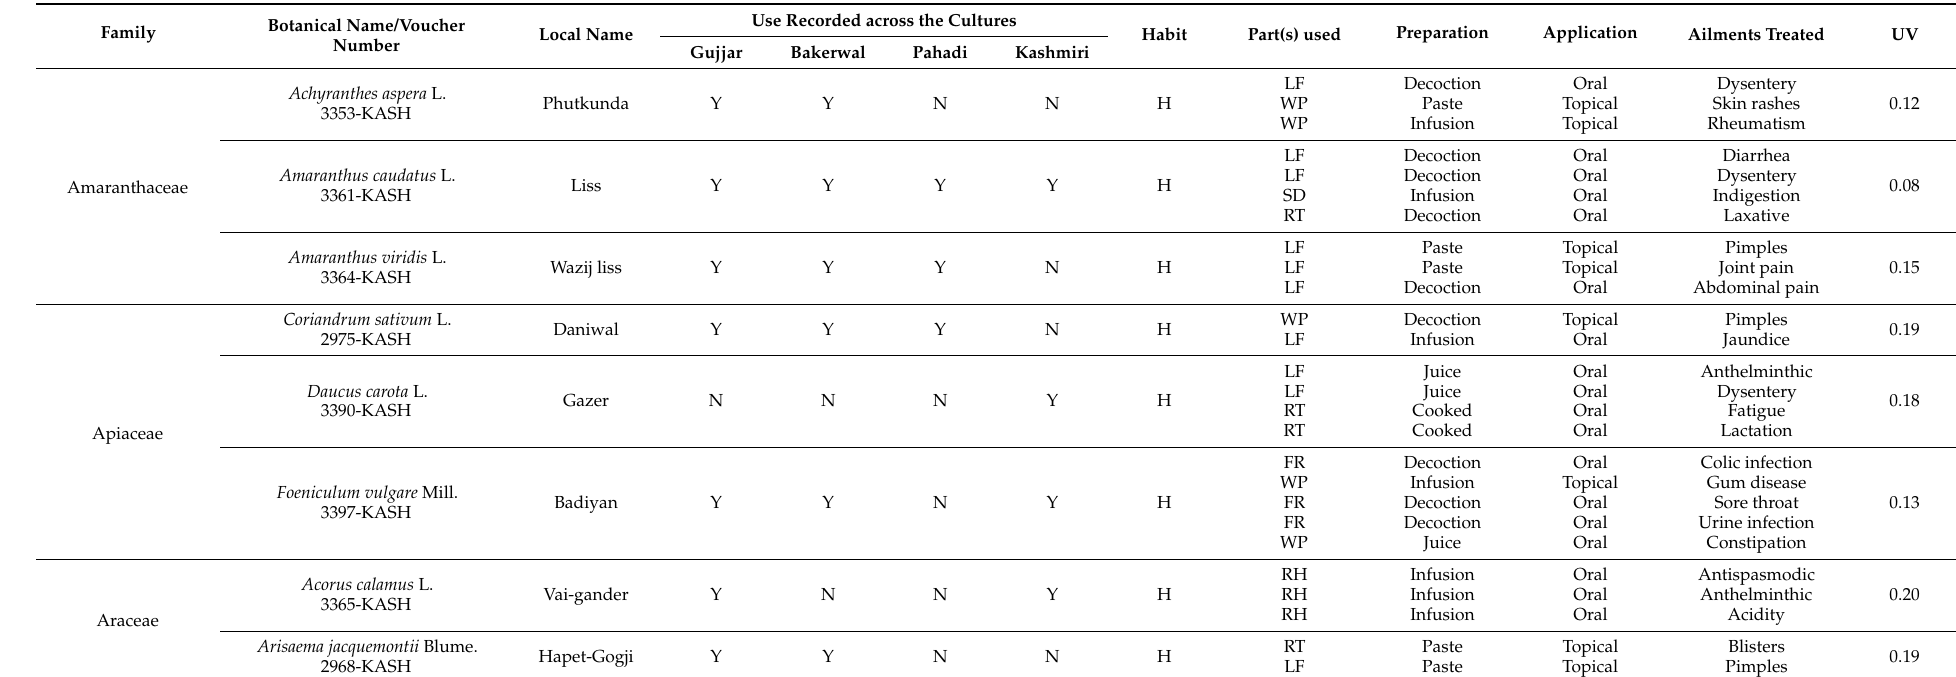
Table 2. Medicinal plants used by the indigenous people of North Kashmir